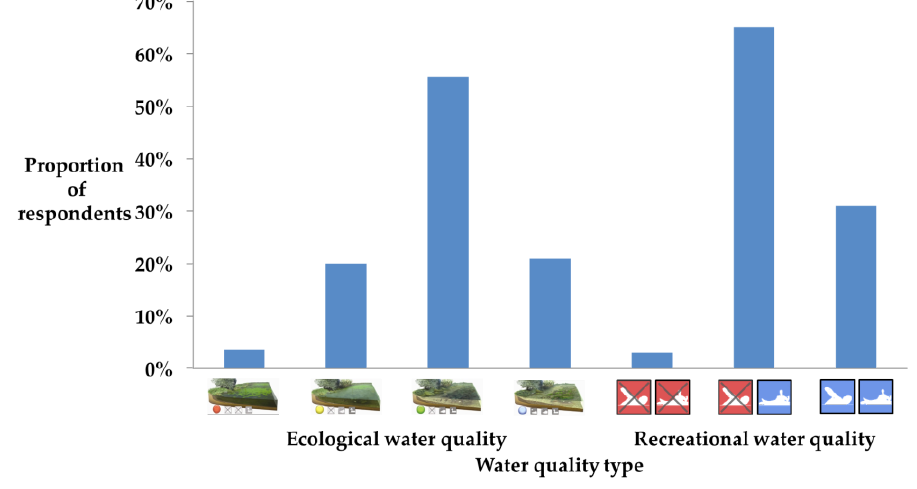
Figure 3. Visitors perceptions of current water quality at the Yare.